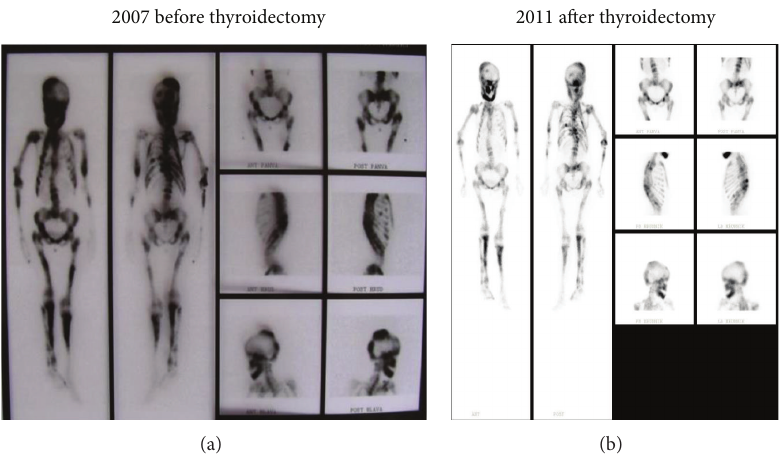
Figure 3: Skeletal scintigraphy with 99mTcHTD before and two years after thyroidectomy.